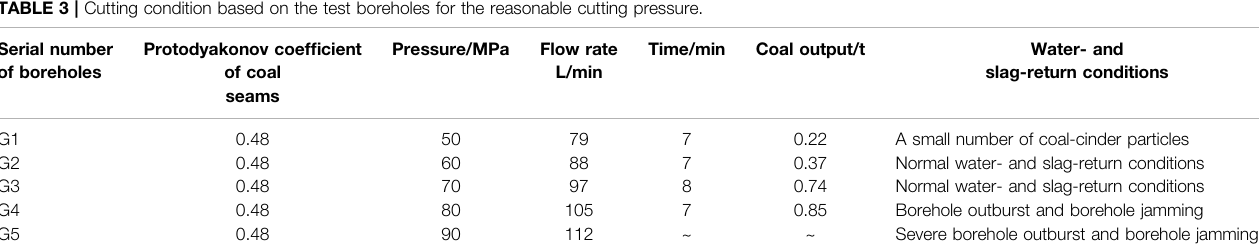
TABLE 3 | Cutting condition based on the test boreholes for the reasonable cutting pressure. Serial number of